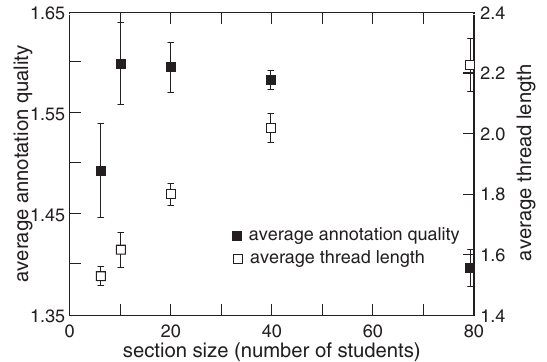
FIG. 7. Average thread length and average annotation quality as a function of section